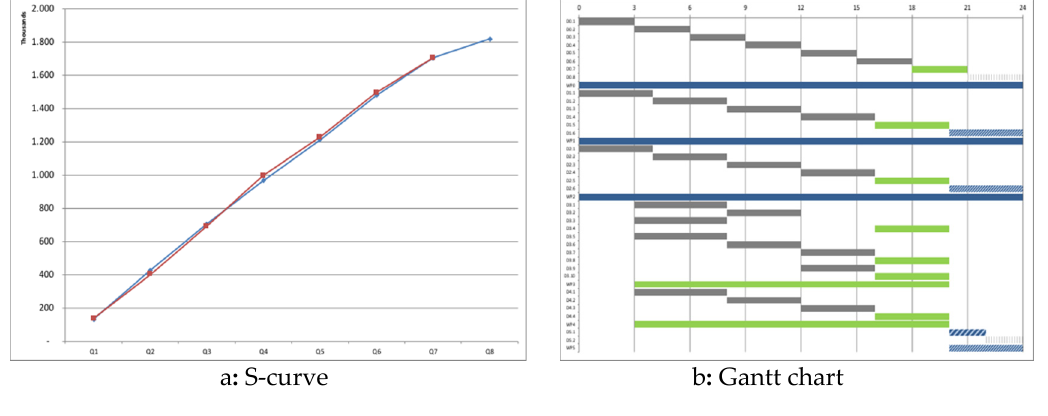
Figure 7. E-Cabin . Figure 7. E-Cabin.